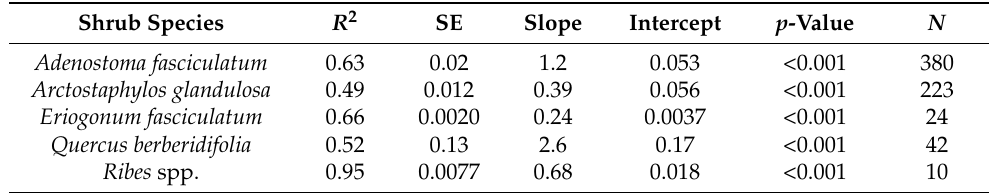
Figure A1. Palmer Drought Severity Index (PDSI) monthly values for 1995–2020 for the South Coast Drainage US Climate Division in Southern California. Anomalous years (wet or drought) are indicated by the horizontal lines in the upper and lower areas of the graph. Drought years were defined as containing 4 or more consecutive months with a PDSI of less than − 3 (severe or extreme) in the growing season (November to May) and a wet year as having 4 or more consecutive months with a PDSI of 2 or greater (moderately moist to very moist) in the same period. Table B1. Linear regression model statistics for biomass estimates using species-specific allometric equations and estimates using the general biomass equation [52]. Individual shrub measurements used in these estimates were collected during a field campaign on the Los Padres National Forest in 2020.